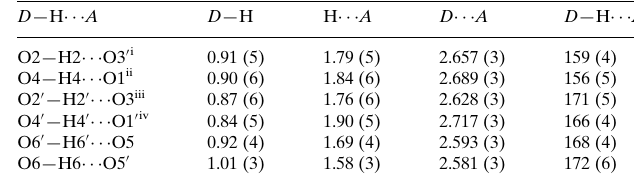
Hydrogen-bond geometry (A˚ , (cid:2)